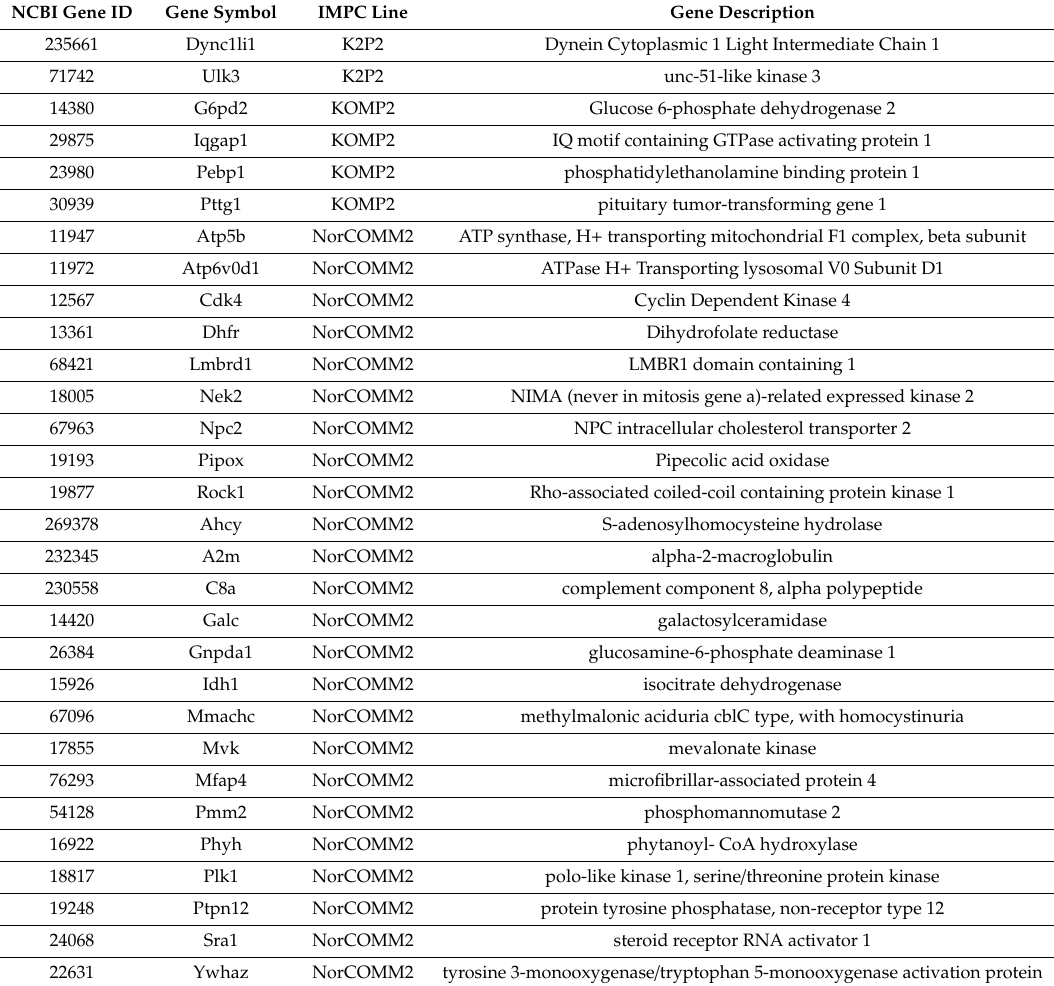
Table 2. Details of the mouse